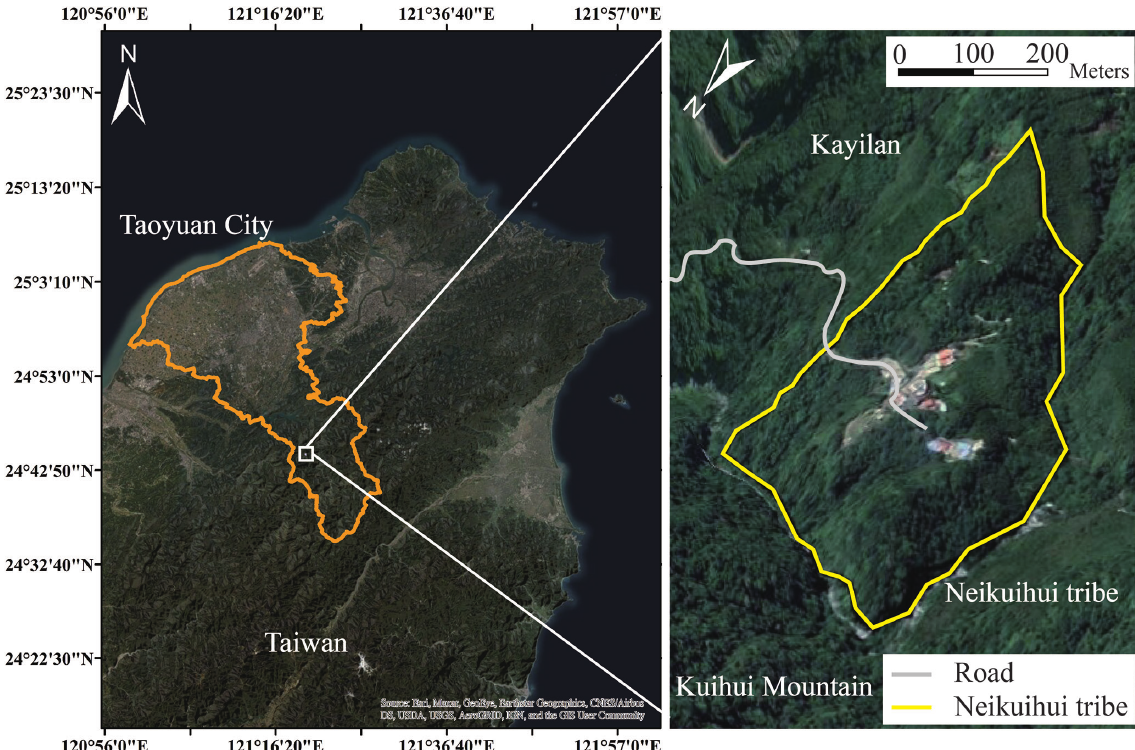
Figure 1. Location of the Neikuihui tribe (image source: Esri, DigitalGlobe, GeoEye, Earthstar Geographics, CNES/Airbus DS, USDA, USGS, AeroGRID, IGN, and the GIS User Community; aerial: ESRI ArcGIS 10.4).